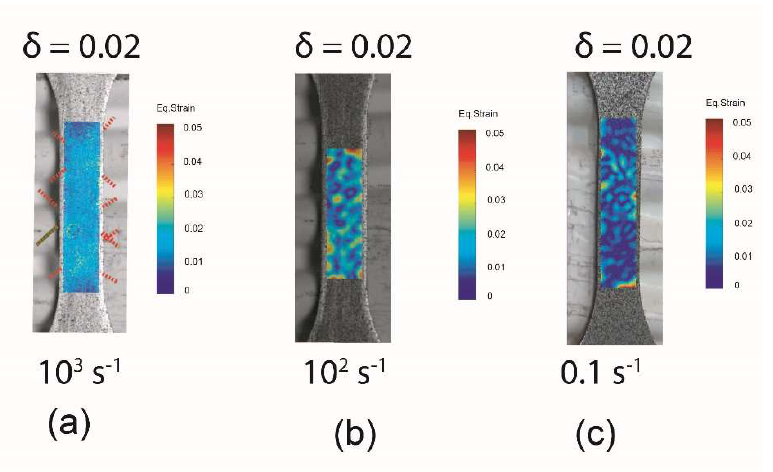
Figure 4. Local equivalent strain distribution in smooth specimens under tension with strain rates of ( a ) 10 3 , ( b ) 10 2 , and ( c ) 0.1 s −1 at the temperature of 673 K; the overage elongation of gauge zone is equal to 2%.